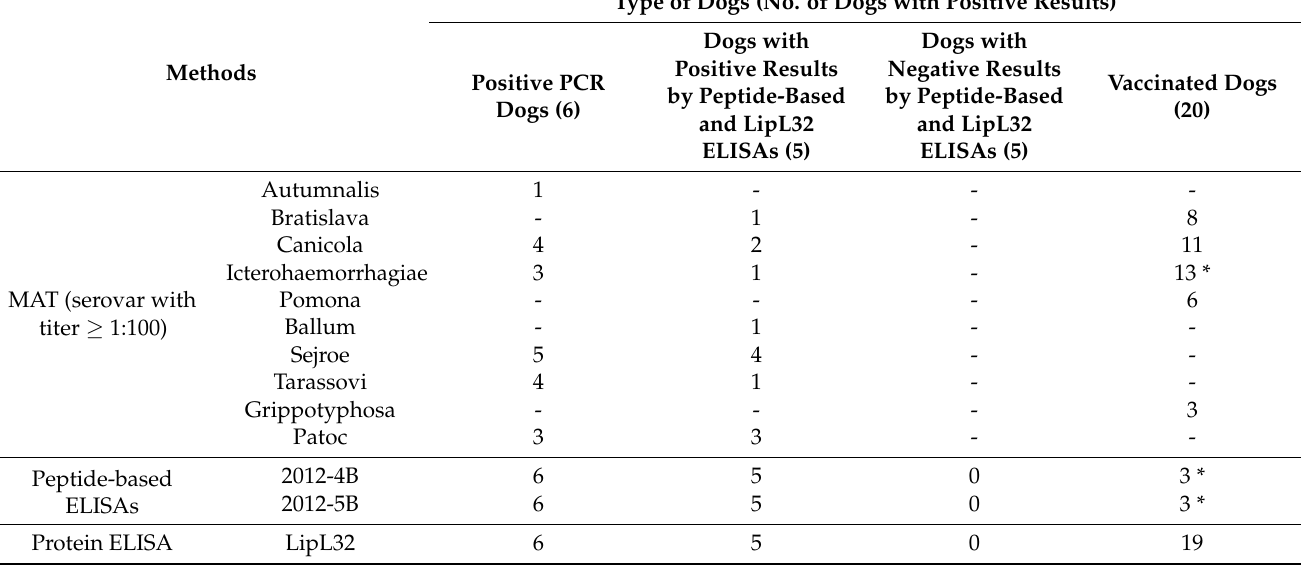
Table 5. The validation of peptide-based and LipL32 ELISAs with MAT results from known true positive dogs’